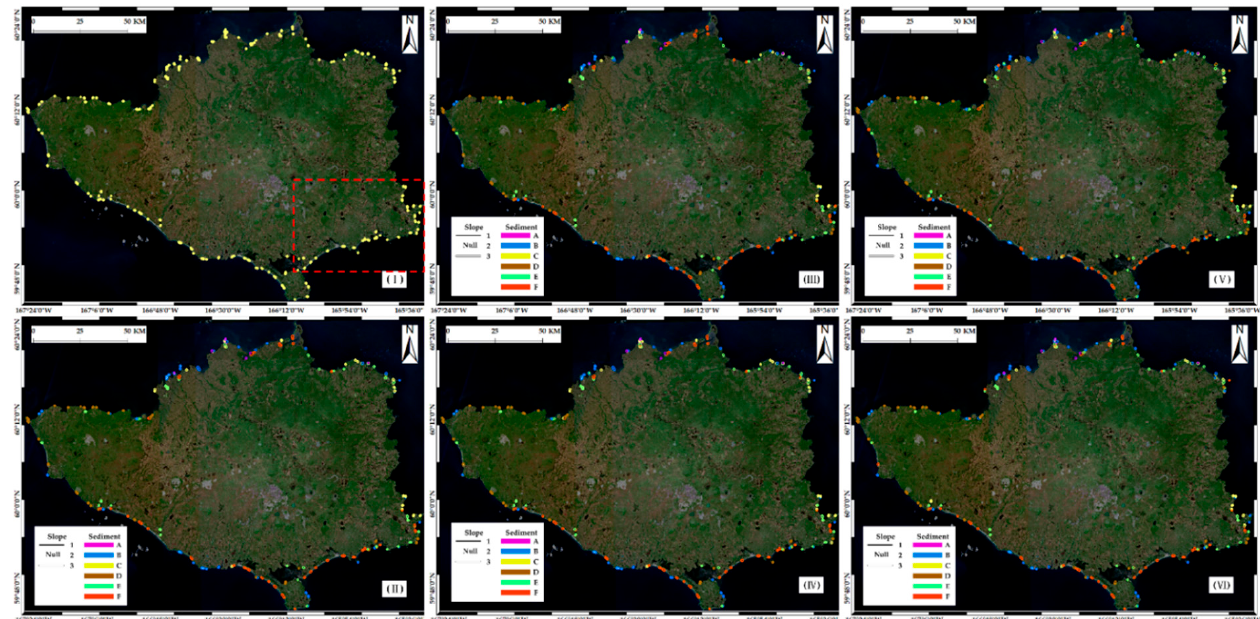
Figure 5. Shore zone type results for Nunivak Island using different methods. ( I ) Sentinel-2 imagery